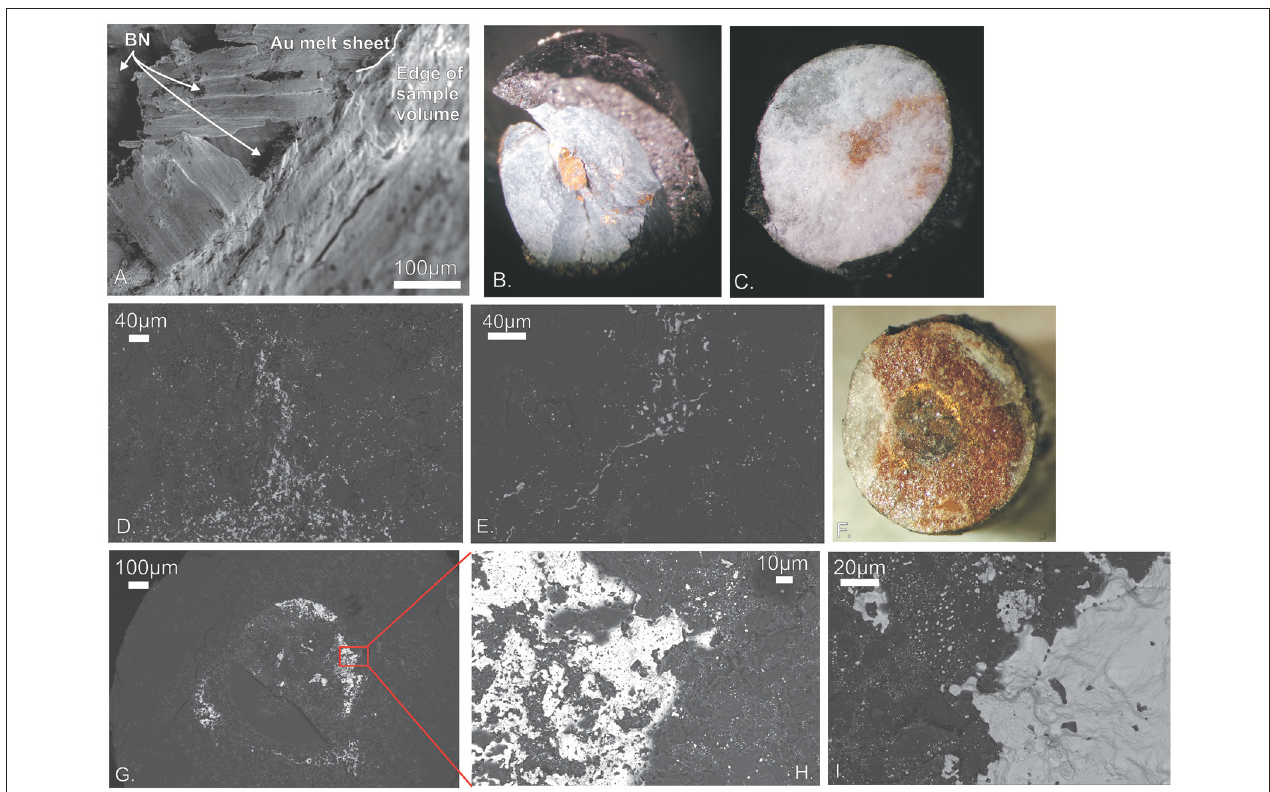
FIGURE 10 | (A) . Secondary electron image showing extensive Au melt sheet(s) in h-BN outer capsule. These sheets (100s µ m wide and long, but a few µ m thick) acted as conduits for Au melt to leave the capsule center (melt-rich region) and pool at the interface between the h-BN and furnace. (B) Magnified view of same sample, showing that most Au is retained in the capsule center, but that there are meandering melt sheets through the outer h-BN capsule and accumulation of melt adjacent to the graphite furnace (black). (C) Section across center of MgO capsule. Texture is different to experiments with h-BN, with Au melt forming extensive melt networks permeating through the coarser-grained MgO capsule, and far fewer broad melt channels. (D) . Back-scatter electron image (BSE) showing Au melt (light gray) in MgO matrix (dark gray) in same sample, showing interconnected Au in the center of the sample (bottom) and an interconnecting melt channel extending upwards. Trapped melt is also present in the surrounding MgO. Au melt loss from the capsule, and accumulation adjacent to the furnace, was also noted. (E) BSE image of part of same sample, showing thin Au melt channel wetting MgO grain boundaries. Grain size in MgO is ∼ 10 µ m (compared to < 1 µ m in h-BN). Pockets of Au melt show typically high dihedral angles in MgO. Submicron blobs of Au melt along grain boundaries represent trapped (residual) melt. (F) Magnified image of Au in MgO experiment with a higher fraction of Au melt in the capsule center (75%). Extensive staining of the surrounding MgO capsule is evident, along with some Au melt sheets. Au melt migrated horizontally and vertically, including into the alumina spacers above and below the capsule. (G) BSE image of same sample showing Au melt (white) in MgO, forming extensive sheets at the boundary between the inner and outer capsule. Higher magnification image (H) shows that brown coloration in (F) is due to submicron blobs of residual Au trapped at grain boundaries. These represent trapped residual melt in dried up melt networks, which mainly transported melt vertically through the sample volume. (I) Similar texture showing extensive Au melt sheet with high dihedral angle in polycrystalline Al 2 O 3 in BSE image of the bottom spacer adjacent to the MgO capsule; once again, fine blobs of Au are interpreted to be residual